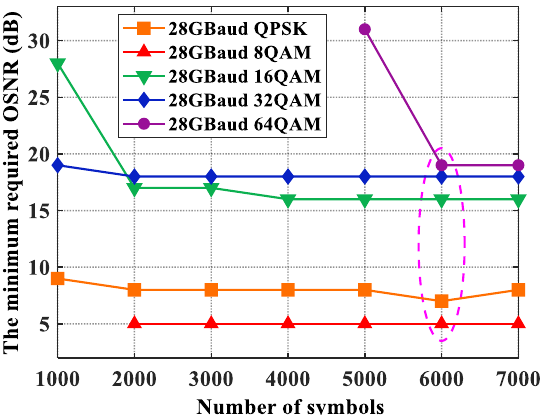
Figure 8. Minimum required OSNR values, with different numbers of symbols for five modulation formats; 6000 symbols is the optimum selection.